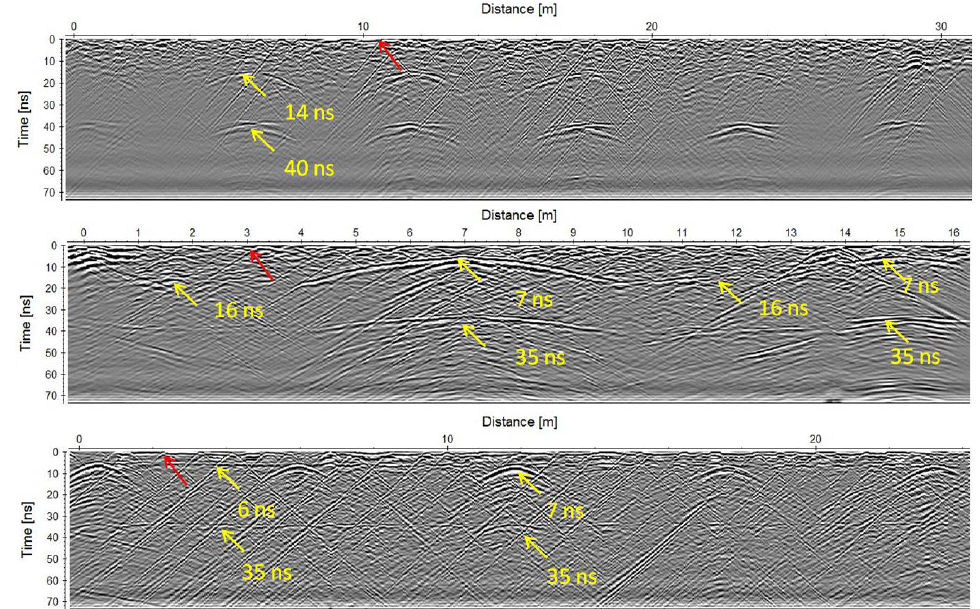
Figure 5. Radar sections recorded with the antennae at 600MHz of the commercial system in the cathedral: L 7 (upper panel), L 13 (middle panel), L 4 (lower panel).